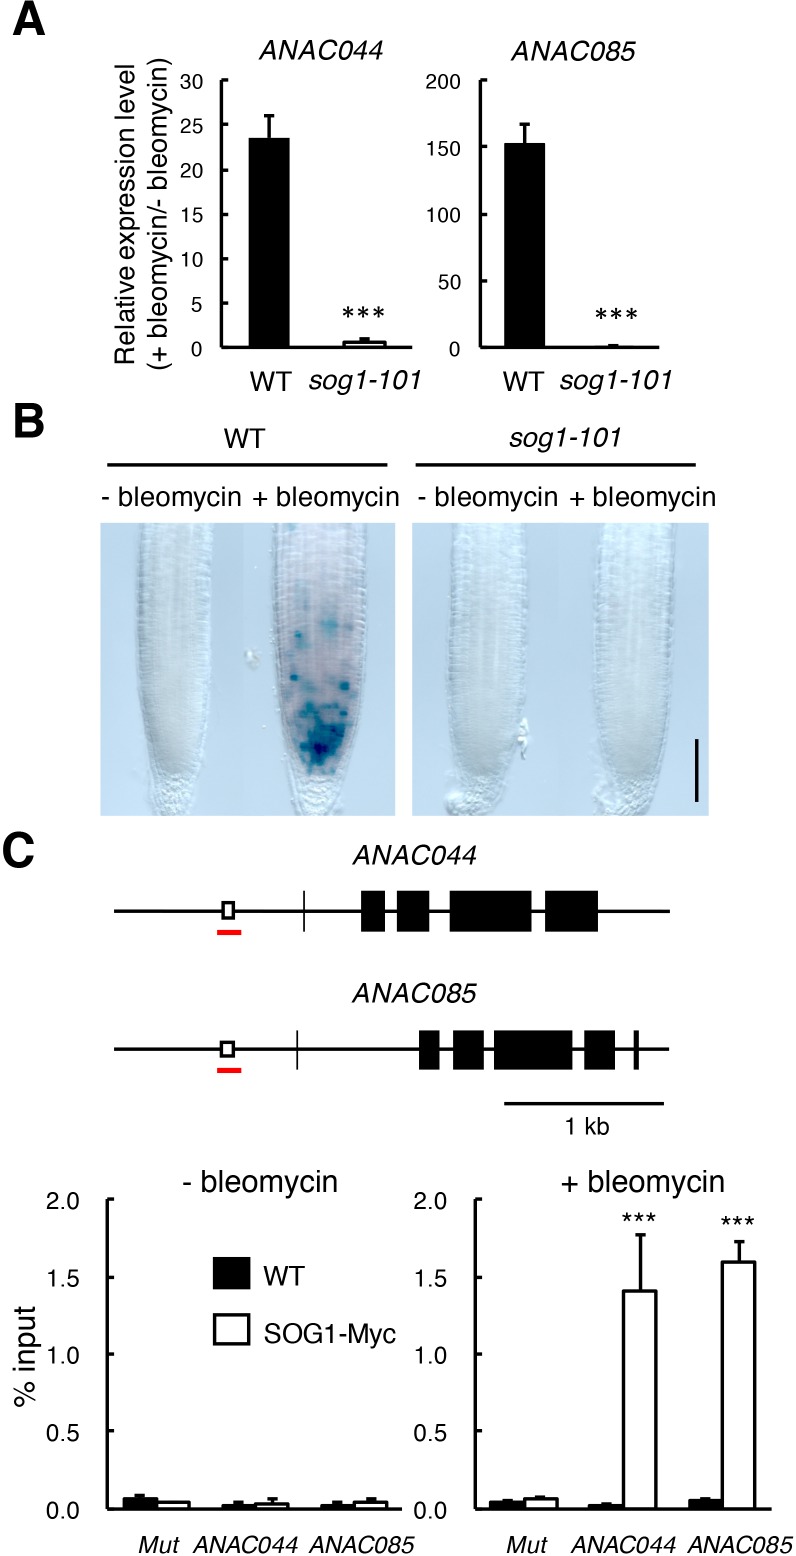
SOG1-mediated induction of ANAC044 and ANAC085.(A) Transcript levels of ANAC044 and ANAC085 in sog1-101. Five-day-old WT and sog1-101 seedlings were treated with or without 0.6 µg/ml bleomycin for 12 hr. The mRNA levels were normalized to that of ACTIN2 and are indicated as fold induction following bleomycin treatment. Data are presented as mean ± SD (n = 3). Significant differences from WT were determined by Student’s t-test: ***, p<0.001. (B) Promoter activity of ANAC044 in the root tip. Five-day-old seedlings of WT and sog1-101 carrying ProANAC044:GUS were transferred to MS medium with or without 0.6 µg/ml bleomycin and cultured for 24 hr, followed by GUS staining. Bar = 100 µm. (C) (Upper) Schematic representation of the genomic regions of ANAC044 and ANAC085. Open and closed boxes indicate SOG1-binding motifs and exons, respectively. Red lines represent the regions amplified in ChIP-qPCR. (Lower) ChIP-qPCR assay. Two-week-old WT and ProSOG1:SOG1-Myc (SOG1-Myc) seedlings were treated with or without 0.6 µg/ml bleomycin. Chromatin bound to SOG1-Myc was collected by immunoprecipitation with anti-Myc antibodies, and qPCR was conducted to amplify the promoter regions of ANAC044 and ANAC085. Mutator-like transposon (Mut) was used as a negative control. The recovery rate of each DNA fragment was determined against input DNA. Data are presented as mean ± SD (n = 3). Significant differences from WT were determined by Student’s t-test: ***, p<0.001.10.7554/eLife.43944.007Figure 1—figure supplement 2—source data 1.Source data.